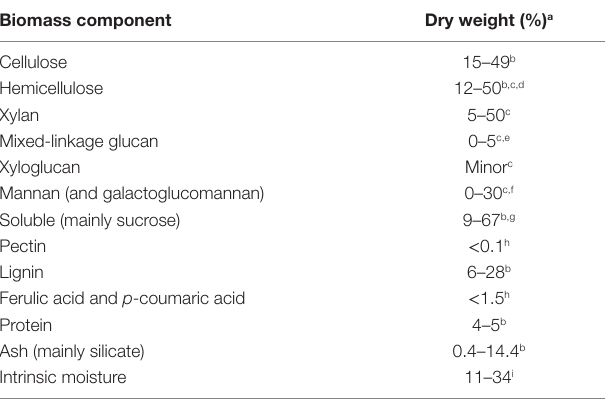
TABLe 2 | The variation of biomass components among vascular plants including grasses, softwoods, and